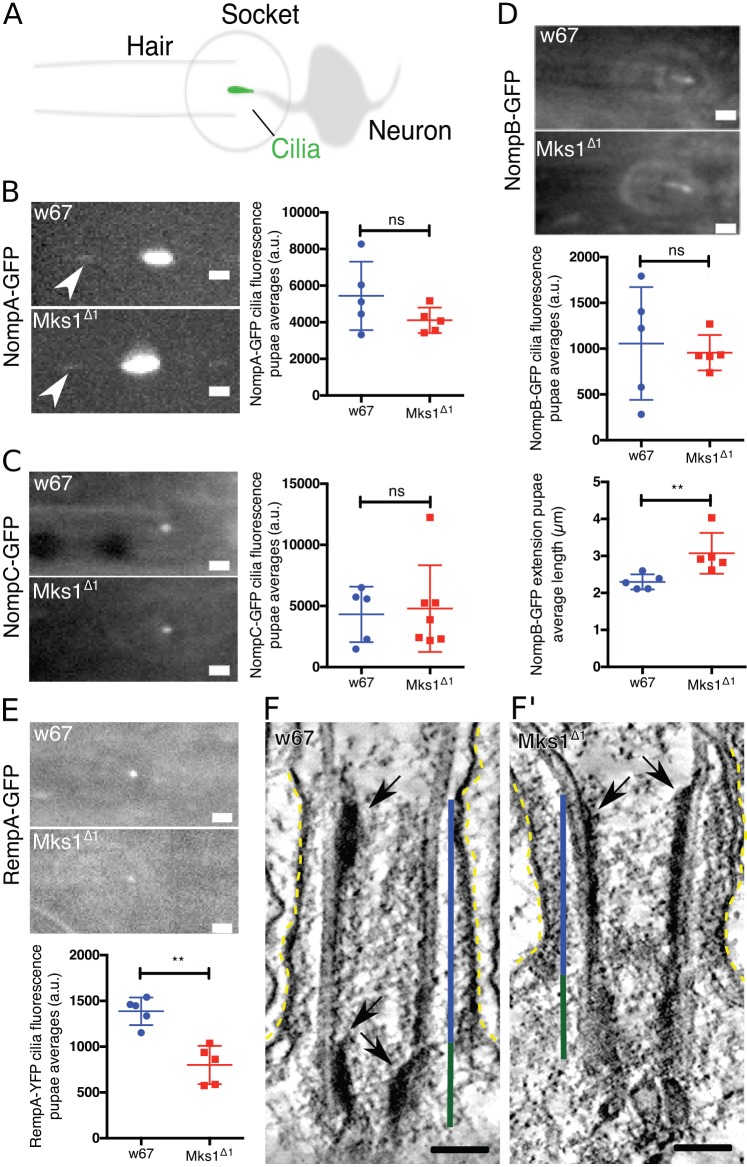
Mks1Δ1 mutant sensory cilia seem to have subtle defects in the localisation of IFT proteins. (A) A schematic illustration of the Drosophila notum hair socket and associated sensory cilia. (B-E) Micrographs and quantification of fluorescence intensity of the transmembrane proteins (B) NompA–GFP (which localises to the dendritic cap of the cilium), (C) NompC–GFP (a ciliary ion channel protein), (D) NompB–GFP (the Drosophila homolog of IFT88) and (E) RempA–GFP (the Drosophila homolog of IFT144) in WT and Mks1Δ1 mutant sensory cilia. The localisation of NompA–GFP and NompC–GFP was not detectably perturbed in Mks1Δ1 mutants, but significantly less RempA–GFP localised in Mks1Δ1 mutant cilia, whereas the average length of NompB–GFP staining (E, bottom panel) revealed that this was slightly longer in Mks1Δ1 mutants. NompA–GFP localised strongly to the base of the bristle, with a dimmer and elongated dot in the bristle hair (arrow). (F,F′) Micrographs show electron tomograms of the BB (dark green lines) and TZ (blue lines) in a WT (F) and an Mks1Δ1 mutant (F′) sensory cilium (ciliary membrane is highlighted by dotted yellow lines). Electron-dense particles similar to IFT trains (arrows) are visible on the BB microtubules facing the TZ lumen in WT. In Mks1Δ1 sensory cilia these particles seem to be dramatically extended. Error bars represent s.d. Significance was assessed using a two-tailed t-test; **P<0.001; ns, not significant. Scale bars: 2 µm in B–D, 100 nm in F,F′.